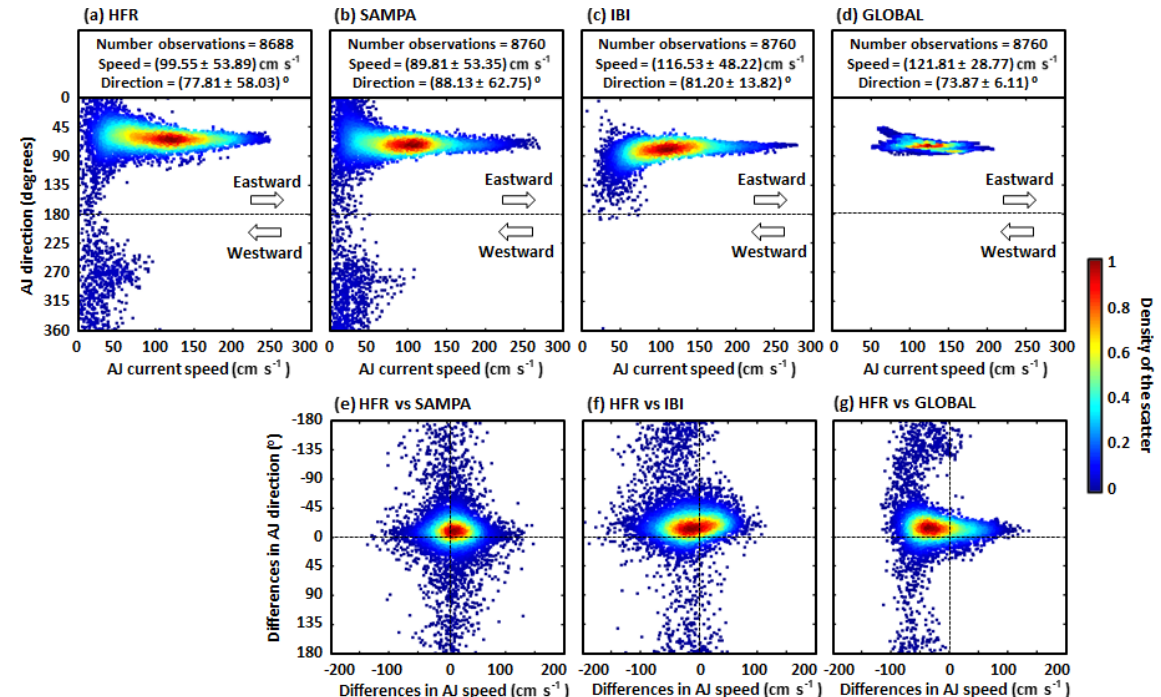
Figure 8. (a–d) Annual (2017) scatter plot of hourly AJ current speed versus direction (angle measured clockwise from the north); estimations provided by (a) HFR, (b) SAMPA, (c) IBI, and (d) GLOBAL. Mean and standard deviation values of both AJ speed and direction are gathered in black boxes; (e–g) annual scatter plot of differences (observation minus model) in AJ speed and direction between (e) HFR and SAMPA, (f) HFR and IBI, and (g) HFR and